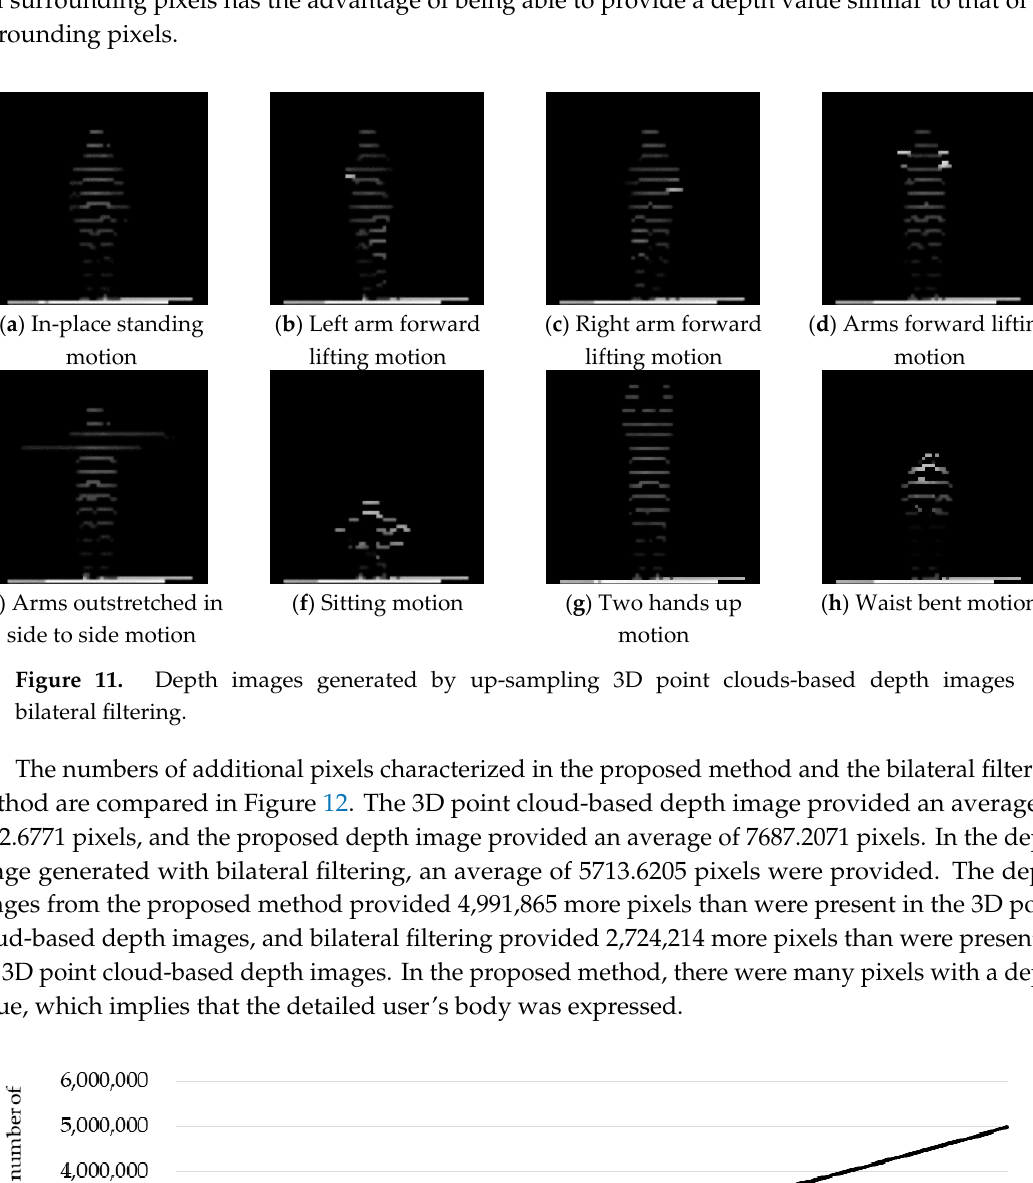
Figure 10. Depth images generated by the proposed method.